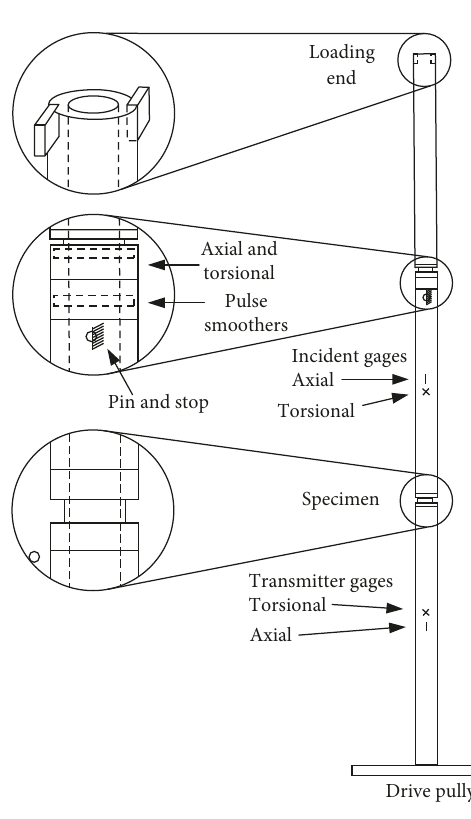
Figure 13: Sketch of the pulse shaping technique for TSHB [57].